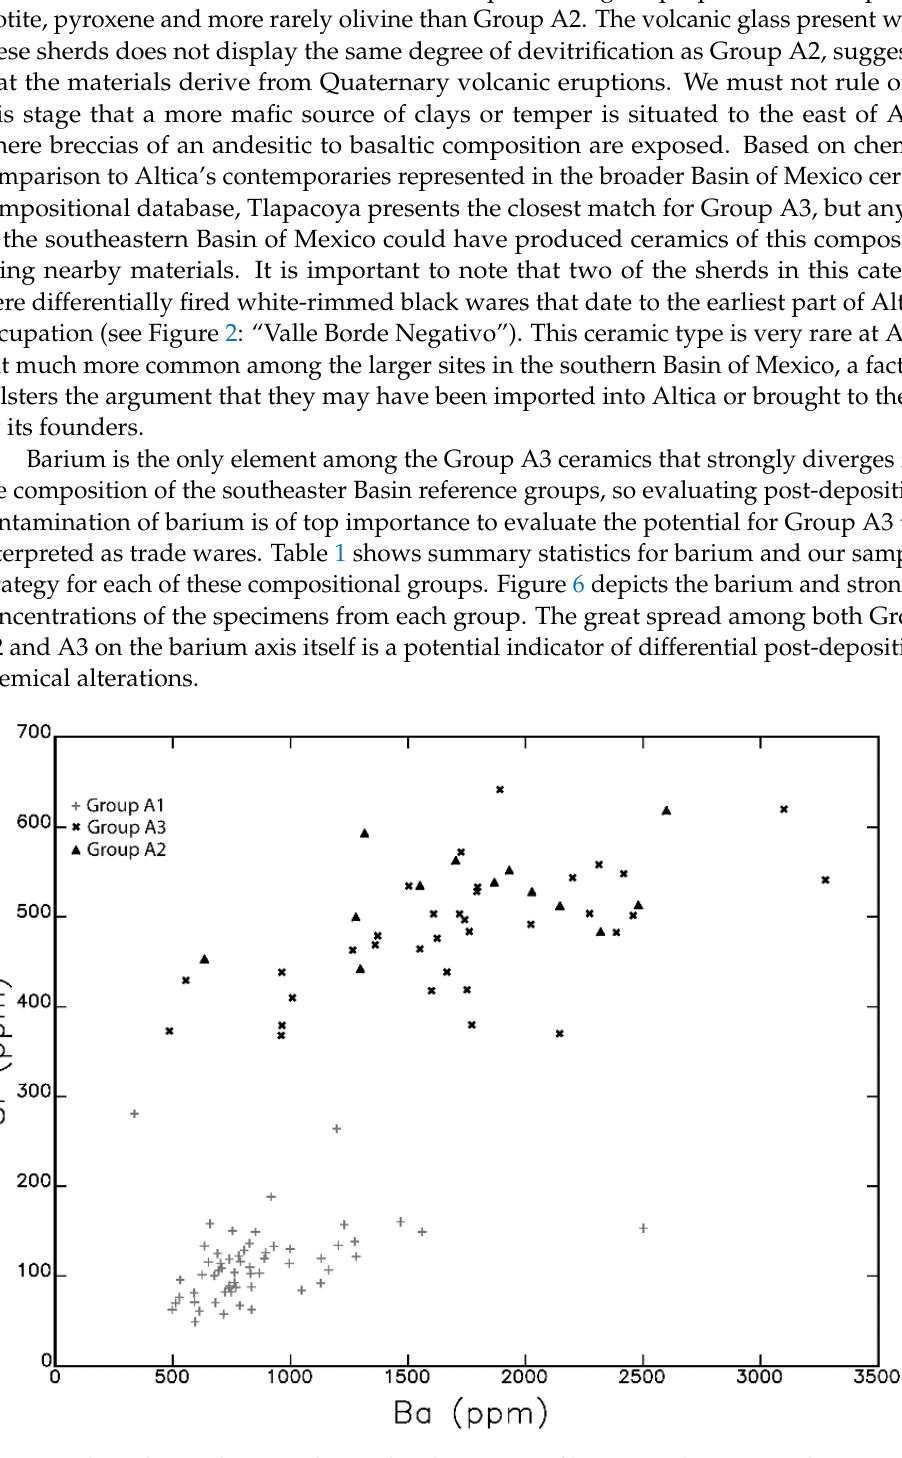
Figure 6. Altica chemical groups depicted on linear axes of barium and strontium determined via bulk